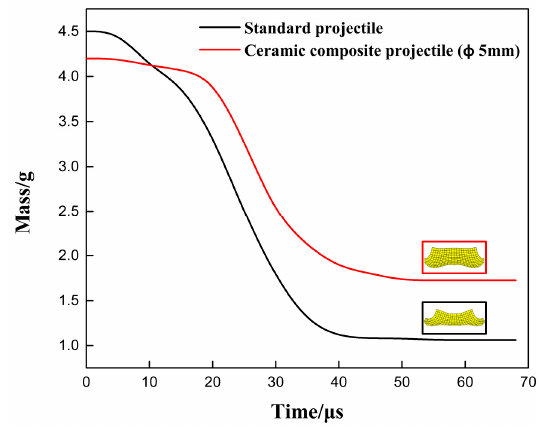
Figure 16. Projectile Core Mass–Time Curve.